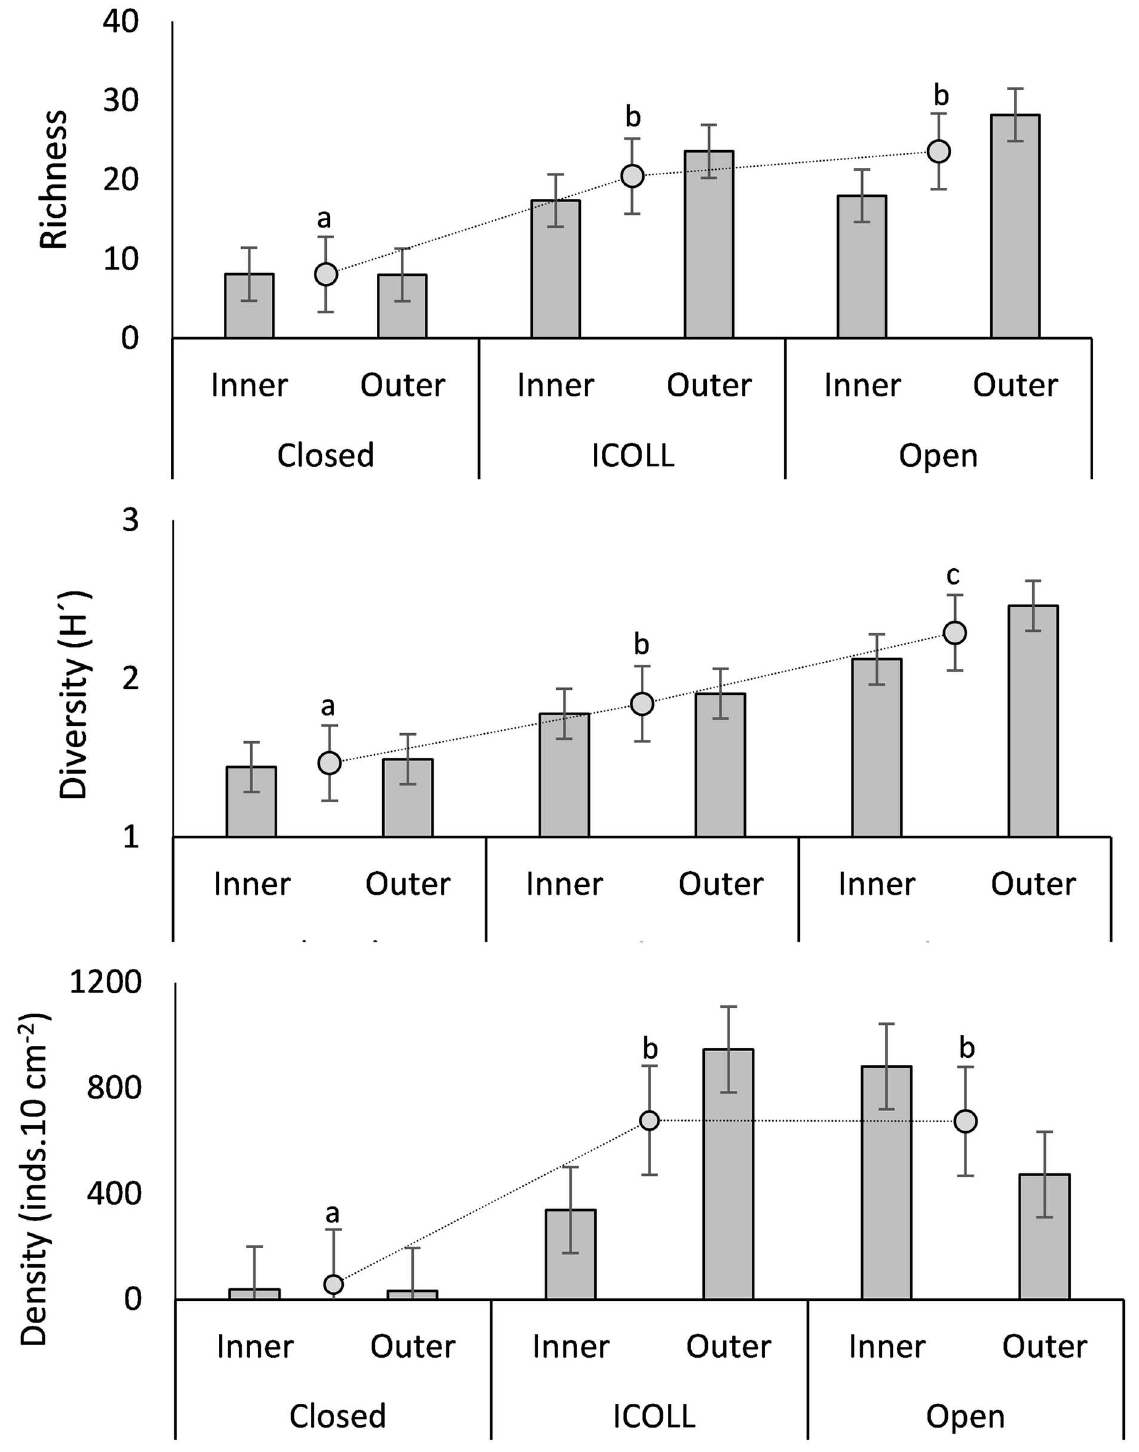
Fig 3. Mean ( ± SE) of nematode number of genera, diversity and density in inner and outer portions (columns) of lagoons, and total mean value ( ± SE) of the descriptor in closed, intermittently open/closed (ICOLL) and open lagoons (gray dot). Different letters indicatesignificantdifferences(p < 0.05)amonglagoontypology.